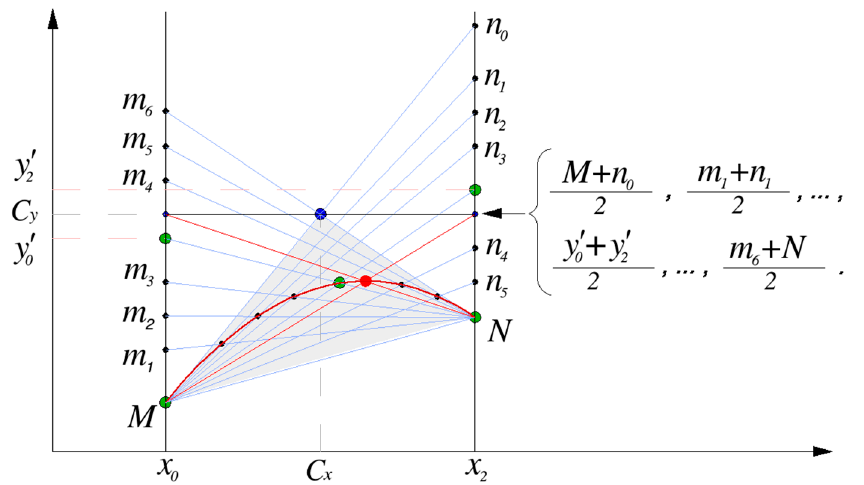
Figure 8. Construction of a Bernstein polynomial. The extremum of the parabola is marked with a red dot and the control point with a blue dot. Green dots indicate points on the parabola, resp. points resulting from extension of straight lines between these points to the boundaries of the interval x x [, ] . The convex hull formed by the control points and is highlighted in grey.